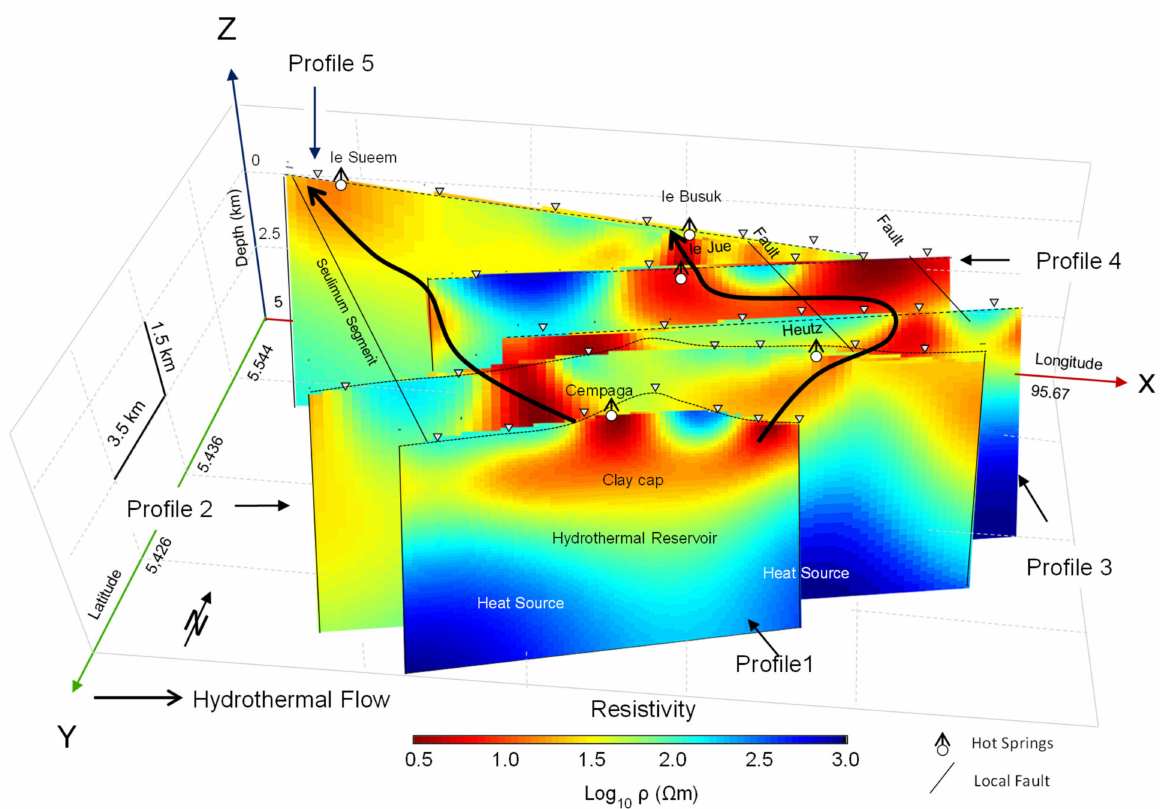
Figure 11. Hydrothermal flow from pseudo-3D resistivity in the Seulawah Agam volcano. The thick black lines represent the estimated hydrothermal